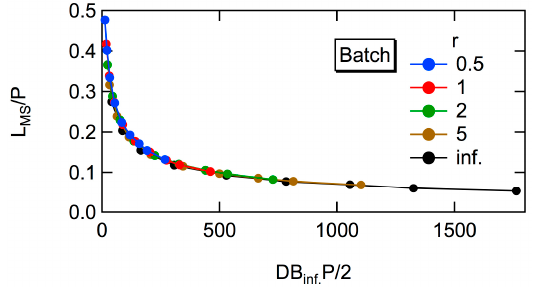
Figure 17. Universal relationship between L MS / P and the number of branch points in a polymer, DB inf P /2 for batch polymerization.